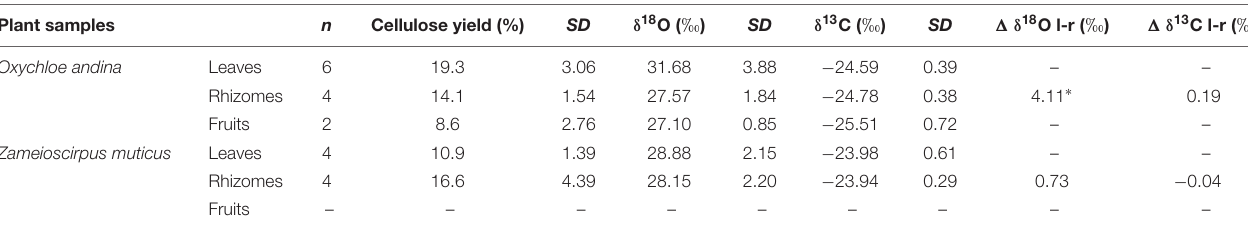
FIGURE 3 | Core images, stratigraphy and age depth model of the core Tuz-694. 14 C-ages with their respective uncertainties are shown on the left side of the core images. The only hiatus in the stratigraphy is present between 98 and 100 cm. The age depth model is based on nine 14 C-dates. The red dots indicate the mean calibrated ages with error bars (2 s). Gray band represents the modeled uncertainty and the black line the 50th percentiles. TABLE 2 | Cellulose isotope values of modern plant samples from the Cerro Tuzgle